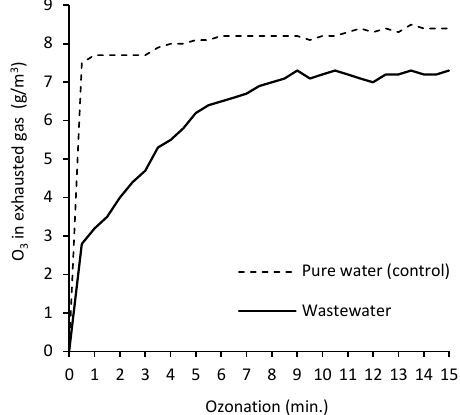
Figure 4. Ozone concentration in the gas exhausted from the reactor for synthetic batik wastewater containing 48 mg/L RB5 and 48 mg/L RO16 at 25 °C.